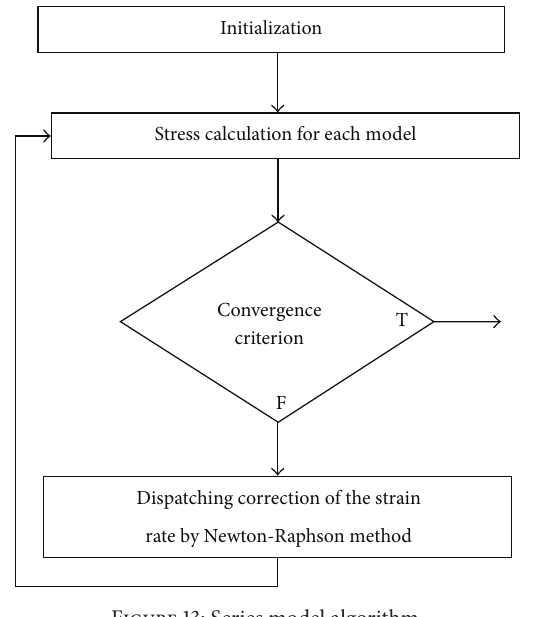
Figure 13: Series model algorithm.